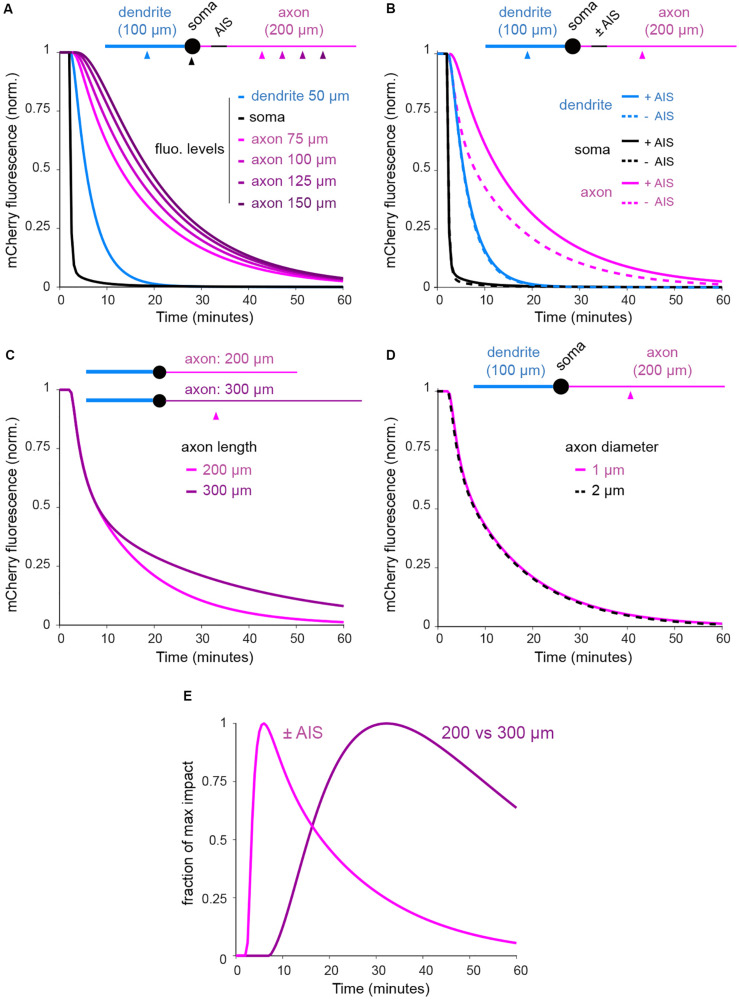
FLIP simulation in simplified neuronal shapes indicates that filtering at the AIS and axonal length shape the exchange of soluble axonal proteins at different temporal scales. (A) Normalized mCherry fluorescence in the soma and 75, 100, 125, and 150 μm from the soma in the dendrite and the axon of a neuron with AIS (see section “Materials and Methods” for details on diffusion-reaction computational model). (B) Decay in the soma and at 75 μm in the dendrite and the axon in a neuron with or without AIS. (C) Decay at 75 μm in 200 and 300 μm-long axons. (D) Decay at 75 μm in 1 and 2 μm-wide axons (the two plots are perfectly overlaid). (E) Normalized impacts of the AIS and axonal length (200 vs. 300 μm) as in (B,C). In (A), note the slowing down of protein exchanges in distal segments of the axon. In (B,C) note the slowing down of protein exchanges by the AIS and with increasing axonal length. In (D) note the absence of effect of axonal diameter. In (E), note that the relative effects of the AIS and axonal length are shifted in time.